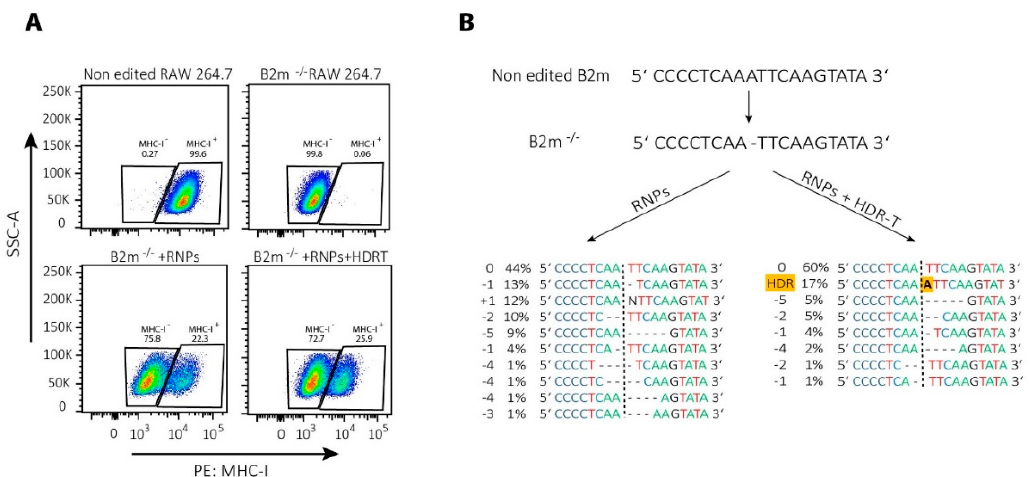
Figure 3. CRISPR/Cas9-mediated correction of frameshift mutations via NHEJ or HDR pathway. To repair a single base-pair deletion in beta-2-microglobulin gene ( B2m ) (NC_000068.8:121981364), cells were nucleofected with CRISPR/Cas9 ribonucleoparticles (RNPs) containing 70 pmol of Cas9 com- plexed with 210 pmol of crRNA (5 ′ -GCGTGAGTATACTTGAATTG-3 ′ ):tracrRNA complexes together with 70 pmol of electroporation enhancer or with the same RNPs in the presence of 100 pmol of single-stranded DNA HDR template (5 ′ -GTTTTCATCTGTCTTCCCCTGTGGCCCTCAGAAACCCCTCAAATTCAAGTATACTCACGCCACCCACCGGAGAATGGGAAGCC-3 ′ ; all components from Integrated DNA Technologies Inc.). Nucleofection with prepared RNPs with or without HDR template in a total volume of 10 µL was performed by using SF cell line 4D-NucleofectorTM X Kit L and a 4D nucleofector X and Core units (all Lonza), using program for RAW 264.7 cell (pulse code: DS136). After nucleofection, cells were expanded for 2 days before they were used for ( A ) FACS analysis of major histocompatibility complex class I (MHC-I) re-expression of the cell surface; or ( B ) DNA extraction to amplify by PCR the region of interest (Forward primer 5 ′ -GACACTGCTAAAAGCCAGGT-3 ′ , reverse primer 5 ′ - CAGATGGAGCGTCCAGAAAGT-3 ′ ; 98 °C 30 ′ ’, 35 cycles (98 °C 5 ′ ’, 55 °C 10 ′ ’, 72 °C 40 ′ ’), 72 °C 2 ′ , using high fidelity DNA polymerase), sequencing it by Sanger sequencing and analyzing the results by using ICE (Synthego) to determine the type of genetic changes induced by NHEJ or HDR.